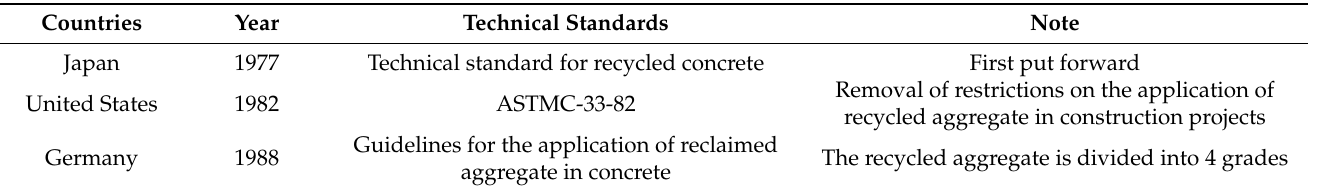
Table 2. Summary of standards and specifications for recycled concrete in various